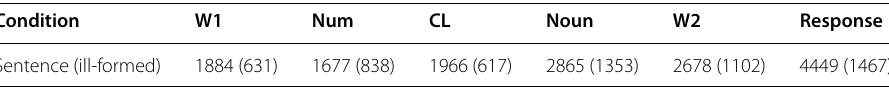
CL Count N (Ill-formed) + +